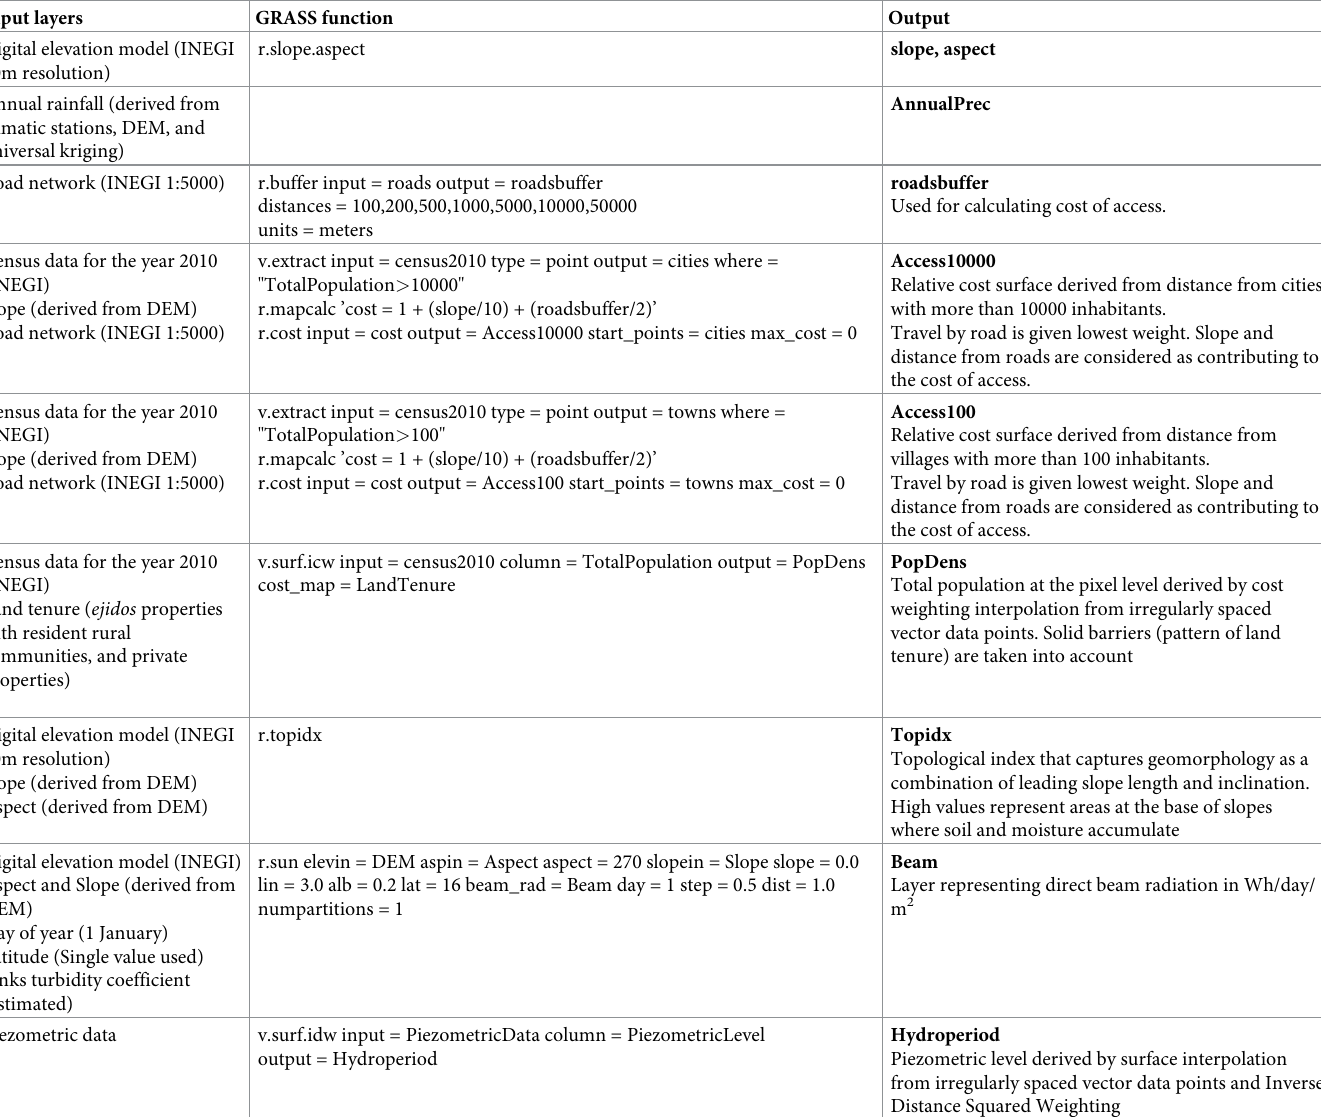
Table 1. Layers used in the analysis. Raster coverages representing drivers, and the layers and GRASS functions used in their